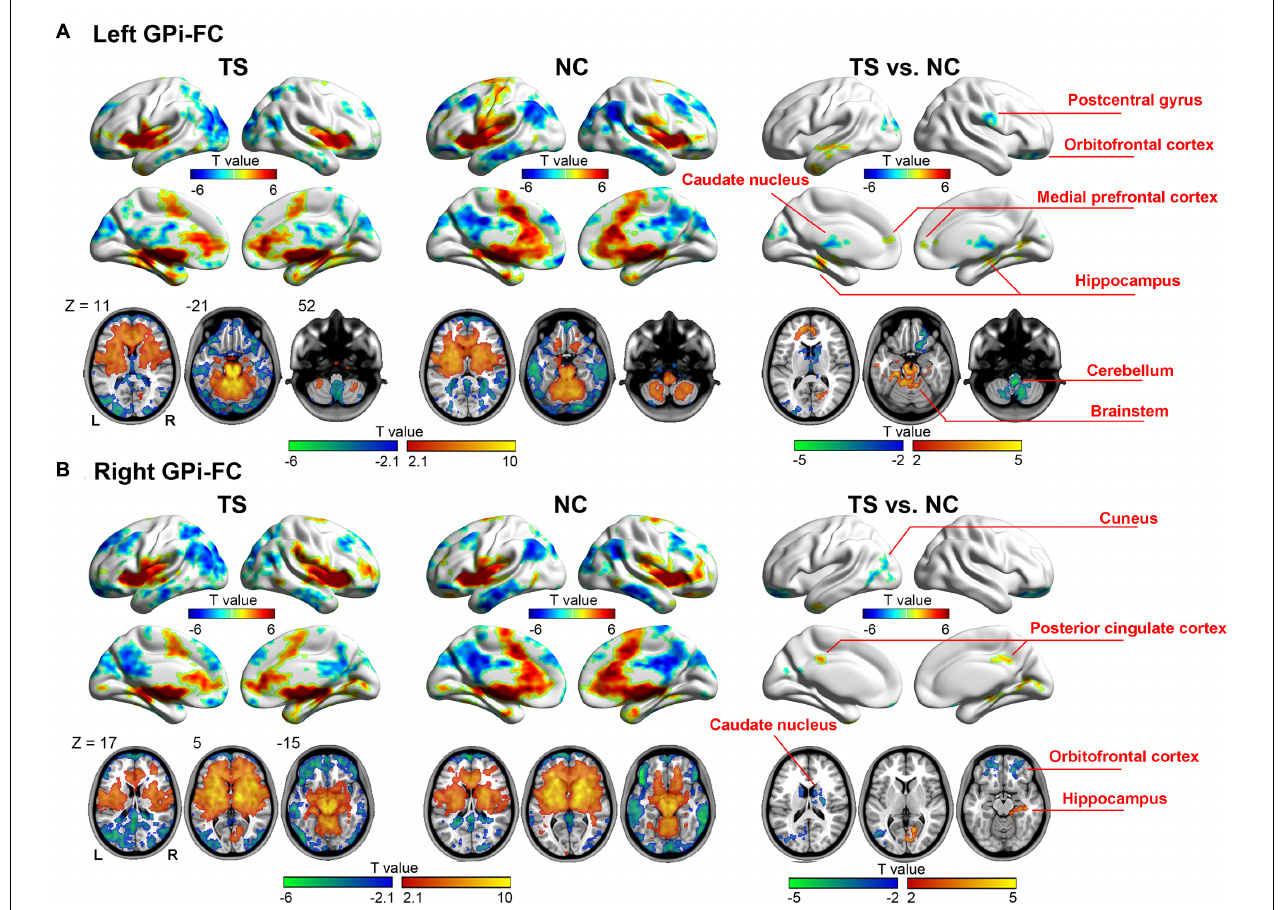
FIGURE 2 | Whole-brain functional connectivity map of the left (A) and right (B) GPi. Warm (cold) colors represent positive (negative) correlation with GPi (the left two columns), and increased (decreased) functional connectivity in patients (the right